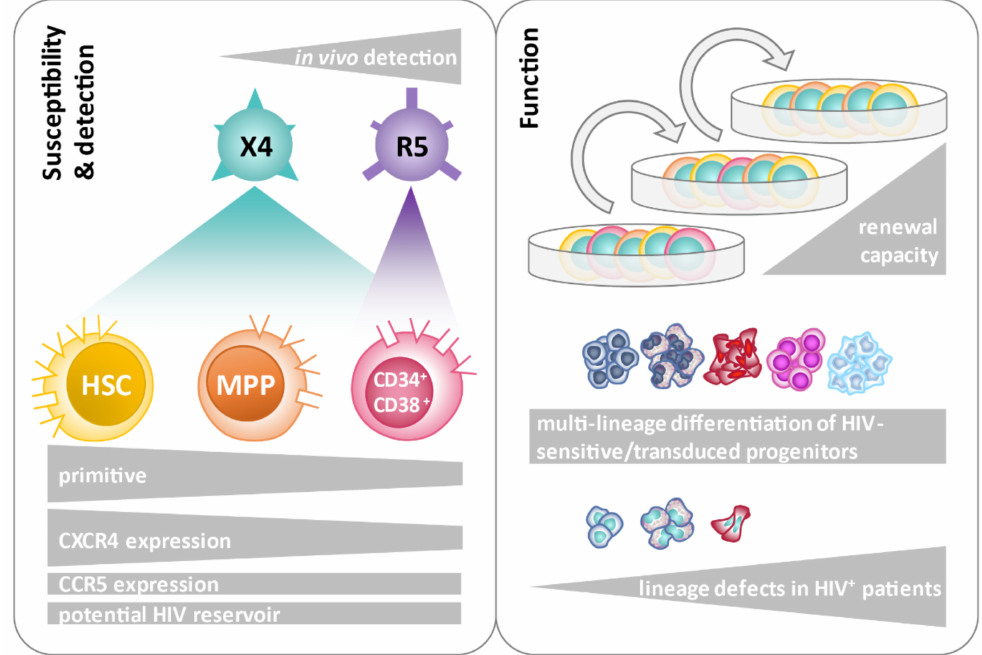
Figure 8. Schematic summary of the findings on the sensitivity of primitive hematopoietic progenitors to HIV-1 infection and functional consequences. The susceptibility of defined hematopoietic stem and progenitor cell subsets to CXCR4 (X4)- and CCR5 (R5)-mediated HIV-1 infection was determined in vitro and in vivo. The cell subsets were analyzed for cell surface expression levels of HIV entry receptors. Functional assays included serial replating of HIV-1-transduced progenitors and colony formation assays in differentiation-inducing medium to confirm the renewal and multi-lineage forma- tion capacity of HIV-1 sensitive/transduced progenitors. A comparative analysis of colony formation between hematopoietic progenitors from HIV-1-infected and uninfected individuals unveiled lineage defects in HIV-1-infected samples. HSC: hematopoietic stem cells; MPP: multipotent